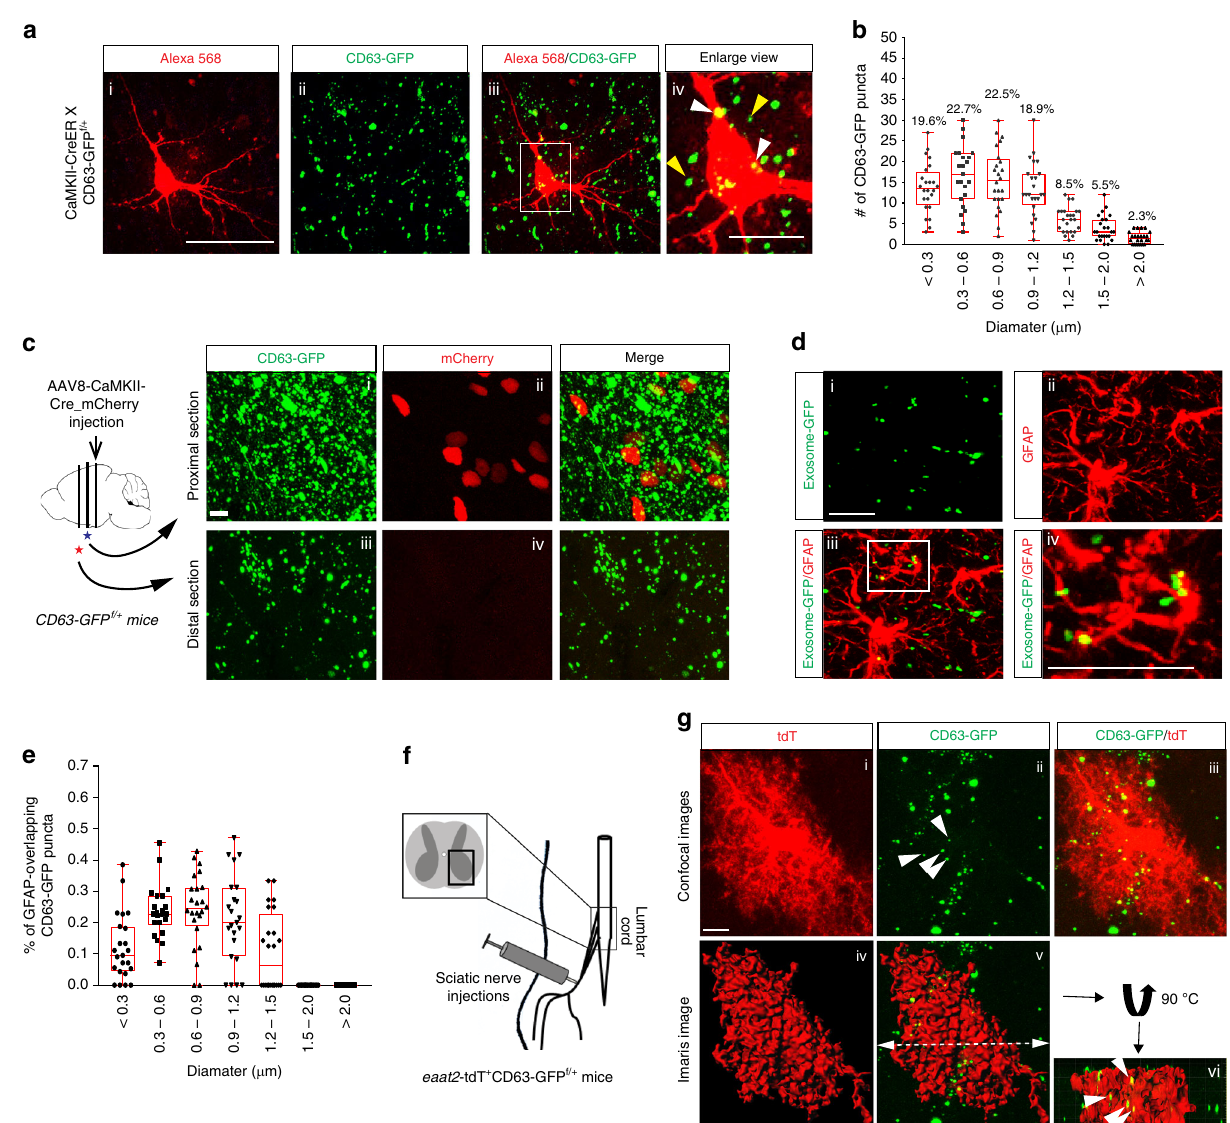
Fig. 3 In situ illustration of neuron-secreted exosomes internalized into astrocytes. Representative confocal images ( a ) and quanti fi cation ( b ) of the number and size of CD63-GFP + puncta in cortical slices of CaMKII-CreER + CD63-GFP f/ + mice. Neurons were patched and fi lled with Alexa-568 dye Subpanels i: Alexa-568 dye fi lled neuron; ii: CD63-GFP fl uorescence: iii: merge of Alexa-568 dye fi lled neuron and CD63-GFP; iv: magni fi ed view of iii. A single dose of 4-OHT (10 mg/kg) was given to P15-16 mice. Scale bar: 50 μ m (i – iii); 15 μ m (enlarged view, iv); n = 24 images/4 mice; c Representative images of induced CD63-GFP + puncta in proximal and distal sections to the injection site. Subpanels i, iii: CD63-GFP fl uorescence; ii, iv: mCherry expression from AAV8- CaMKII-Cre_mCherry virus; The virus injection site and brain sections analyzed are illustrated in the diagram. Red star: distal sections; blue star: proximal sections; Scale bar: 40 μ m; d Representative confocal images of the internalization of neuron-secreted exosomes (CD63-GFP + puncta) into GFAP + astrocytes in AAV8-CaMKII-Cre_mCherry virus injected CD63-GFP f/ + mice. Subpanels i: CD63-GFP fl uorescence; ii: GFAP immunostaining: iii: merge of CD63-GFP and GFAP staining; iv: magni fi ed view of iii; Scale bar: 50 μ m (i – iv); e Quanti fi cation of the size and number of CD63-GFP + puncta that overlap with GFAP + astrocytes. n = 24 images/4 mice; f Diagram of peripheral sciatic nerve injections of AAV9-CaMKII-Cre/FluoroGold to eaat2 -tdT + CD63- GFP f/ + mice. g Representative confocal and Imaris 3D images for astroglial localization of neuron-derived CD63-GFP + exosomes. Subpanels i: tdT + astrocyte; ii: CD63-GFP fl uorescence; iii: merge of CD63-GFP and tdT fl uorescence; iv: converted 3D astrocyte domain from (i); v: merge of CD63-GFP and converted 3D astrocyte domain; vi: the upper part of the transected image in (v) with 90 degree outward rotation; Scale bar: 10 μ m; The dashed line indicates where the transection was. The upper part of the transected image turns 90 degree outward to show the representative CD63-GFP + puncta (white arrows) inside tdT + astrocytes. The data was presented in the box and whisker plot with de fi ned elements, median (center line), upper and lower quartiles (bounds of box), and highest and lowest values Fig. 3b. As CD63 + ILVs are derived from endosome and CD63 are signi fi cantly larger than the typical size (50 – 150 nm) of is also known to label lysosome inside the cell, it is likely that exosomes prepared from cultures, this could be due to the fi ltration procedure used (0.22 μ m fi lter) in preparing in vitro the larger CD63-GFP + puncta label these subcellular organelles exosomes and resolution limit of typical confocal microscopy, and are therefore intracellularly localized. Although the overall which is unable to resolve smaller puncta. size distribution of the majority of CD63-GFP + puncta signals